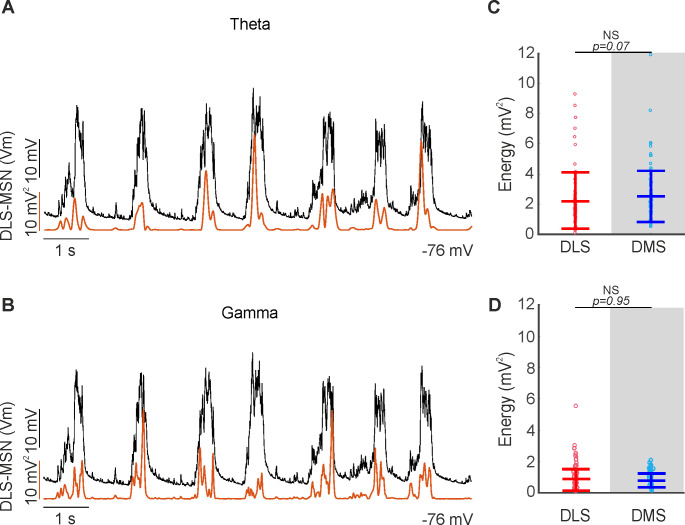
Theta and Gamma band in membrane potential of dorsal striatum.(A) Representative example of the energy of the theta band (orange trace) of a DLS-MSN during SWO regime. (B) Representative example of the energy of the Gamma band (red trace) of a DLS-MSN during SWO regime. (C) Energy of the Theta band of DLS- and DMS-MSNs. (D) Energy of the Gamma band of DLS- and DMS-MSNs. Same neuron in A and B. p Values obtained using the Wilcoxon Rank-sum test.